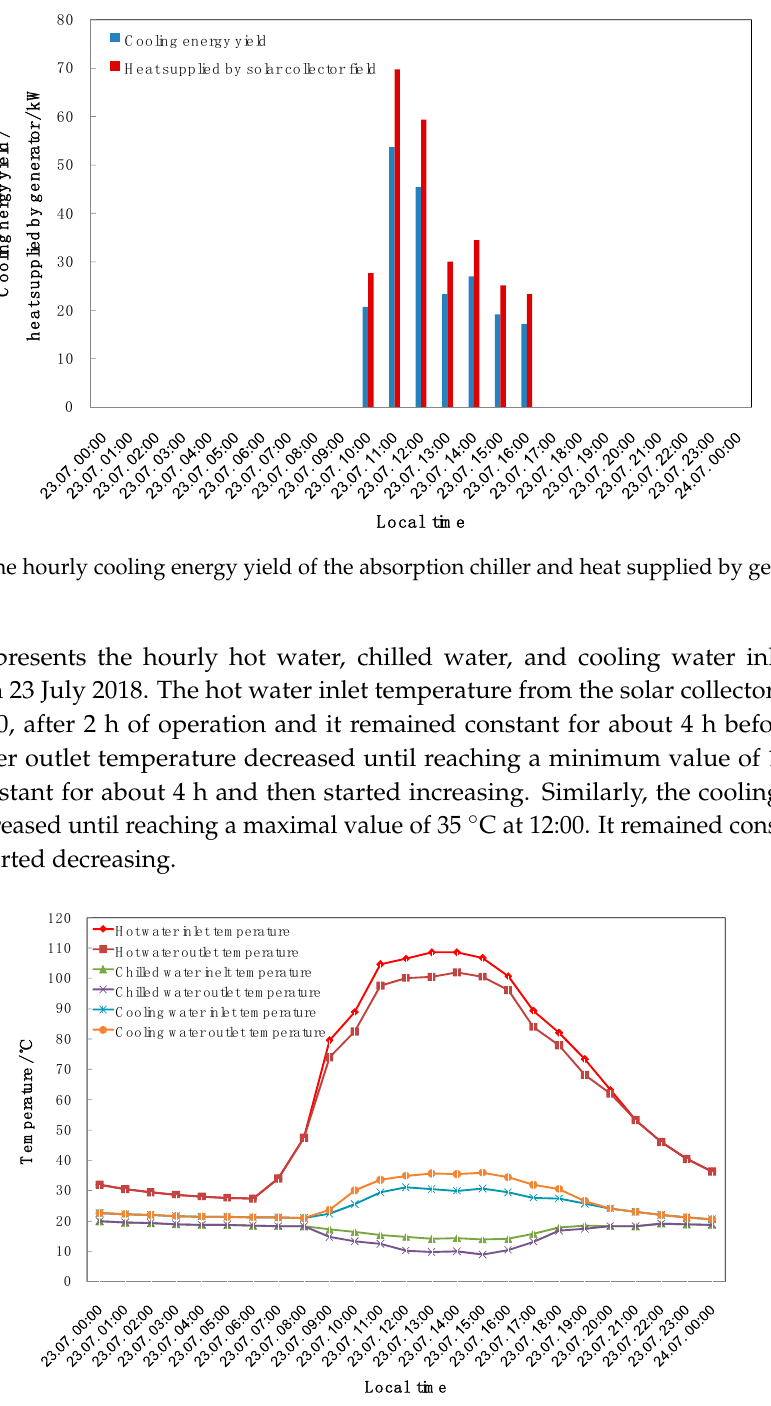
Figure 14. The hourly hot water, chilled water, and cooling water inlet and outlet temperatures on 23 July 2018.